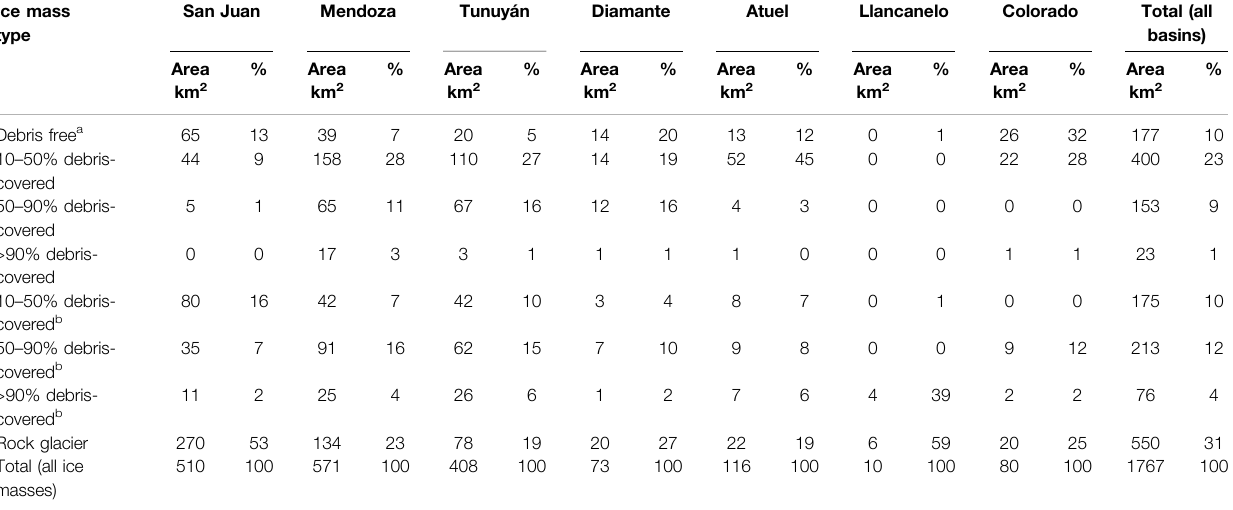
TABLE 1 | Glacier area for different types and debris coverage in the main river basins of the Central Andes of Argentina. Percentages refer to total glacier area (all types) in each basin. Ice mass